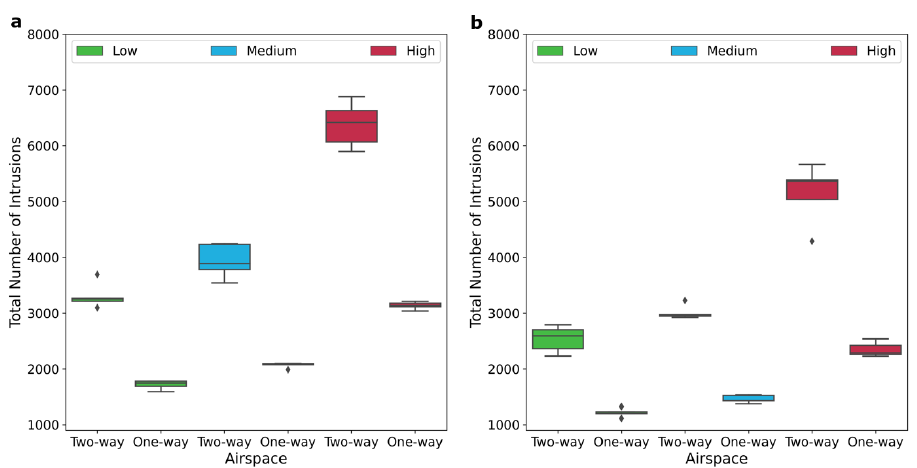
Figure 8. The total number of pairwise intrusions for the two-way and one-way urban airspace concept for low, medium, and high traffic demands. ( a ) Without conflict resolution. ( b ) With conflict resolution.